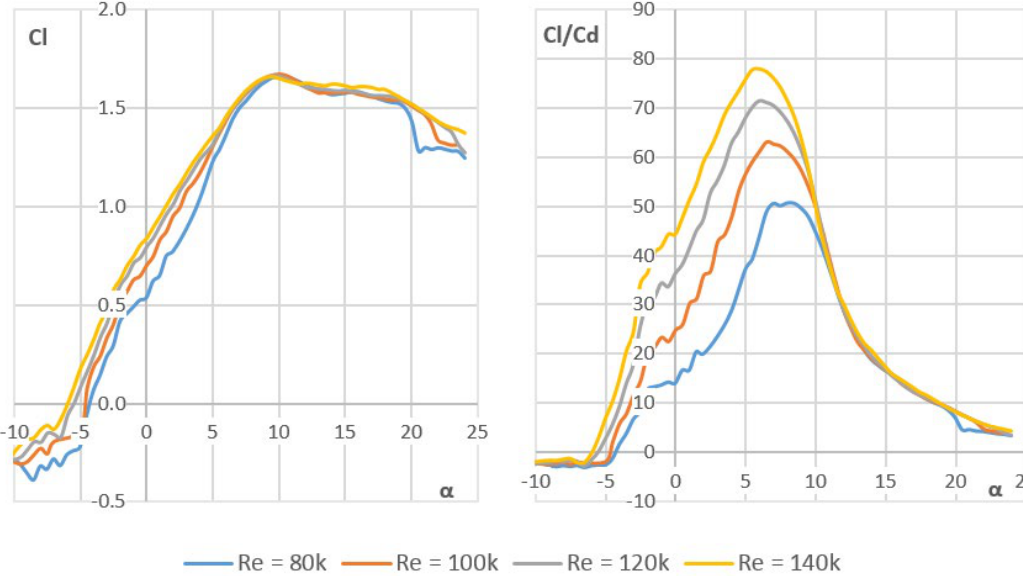
Figure 2. XFOIL polars of the lift coefficient ( left ) and the lift to drag ratio ( right ) as a function of the angle of attack for the Wortmann FX 63-137 airfoil.